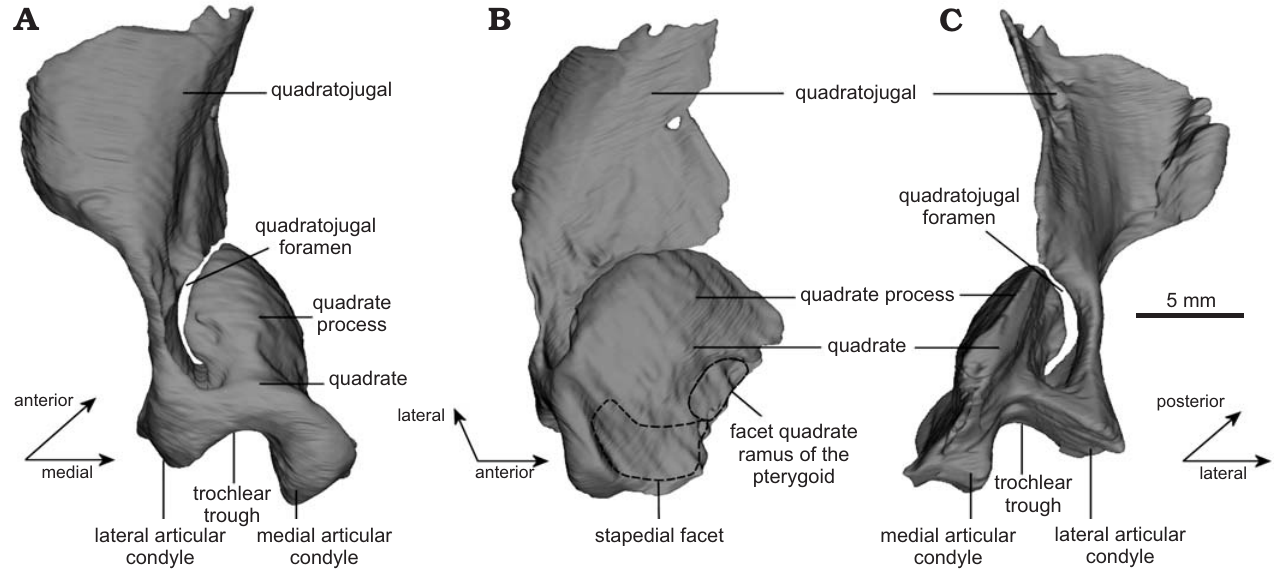
Fig. 5. Virtual reconstruction of the left quadrate-quadratojugal complex of the non-mammalian synapsid Pristerodon mackayi Huxley, 1868 (MB.R.985) from the Late Permian of Biesjespoort, South Africa; in ventral ( A ), medial ( B ), and anterior ( C )